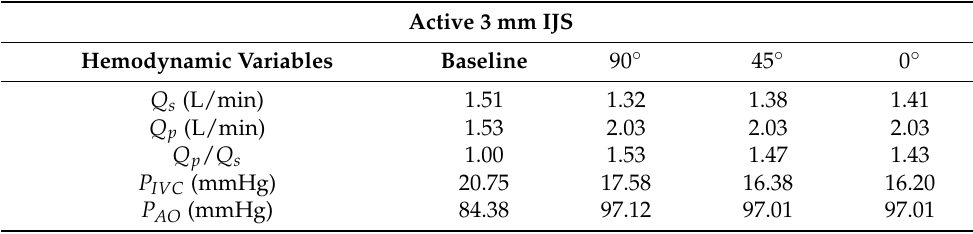
Table 4. Pressure and flow measurement for active 3 mm IJS with varying